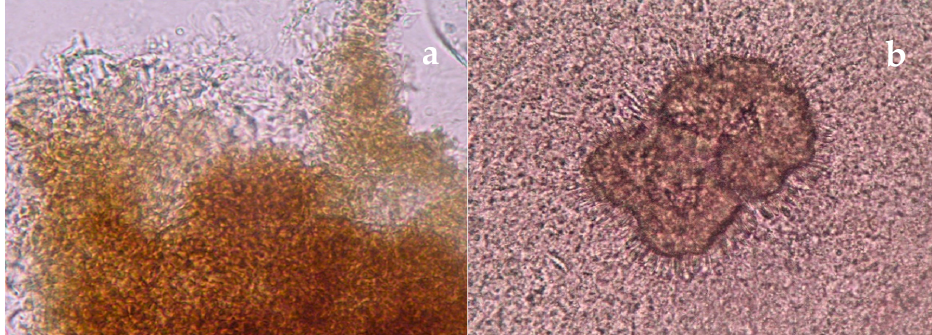
Table 1. Optimal diagnostic methods in a well provided laboratory—positive